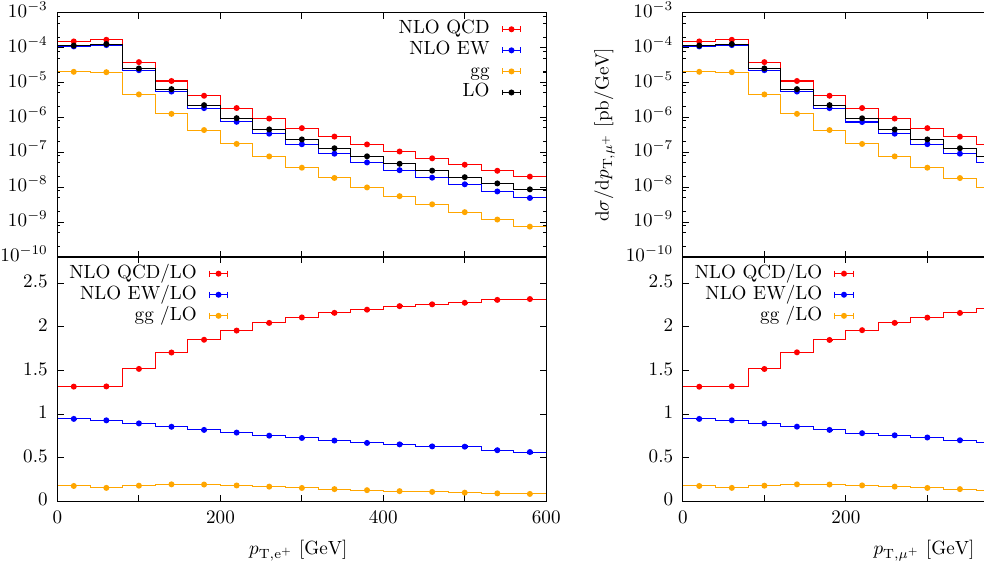
Fig. 16 Upper panels: differential distributions in the transverse EW and gg contributions with respect to the LO (red, blue and orange lines, respectively). For all curves the central value of the factoriza- momentum of the positron ( p T , e + ) and the antimuon ( p T ,μ + ) for the √ s = 13TeV for the event selection of tion and renormalization scales is used and the error bars correspond to process pp → e + e − μ + μ − at the statistical integration uncertainties. Note that the same PDF set is Eq. (4.11). The LO results (black lines) are compared to the ones at employed for both the LO and NLO predictions NLO QCD (red lines) and NLO EW (blue lines). The gg contribution is also shown (orange lines). Lower panels: ratio of the NLO QCD, NLO